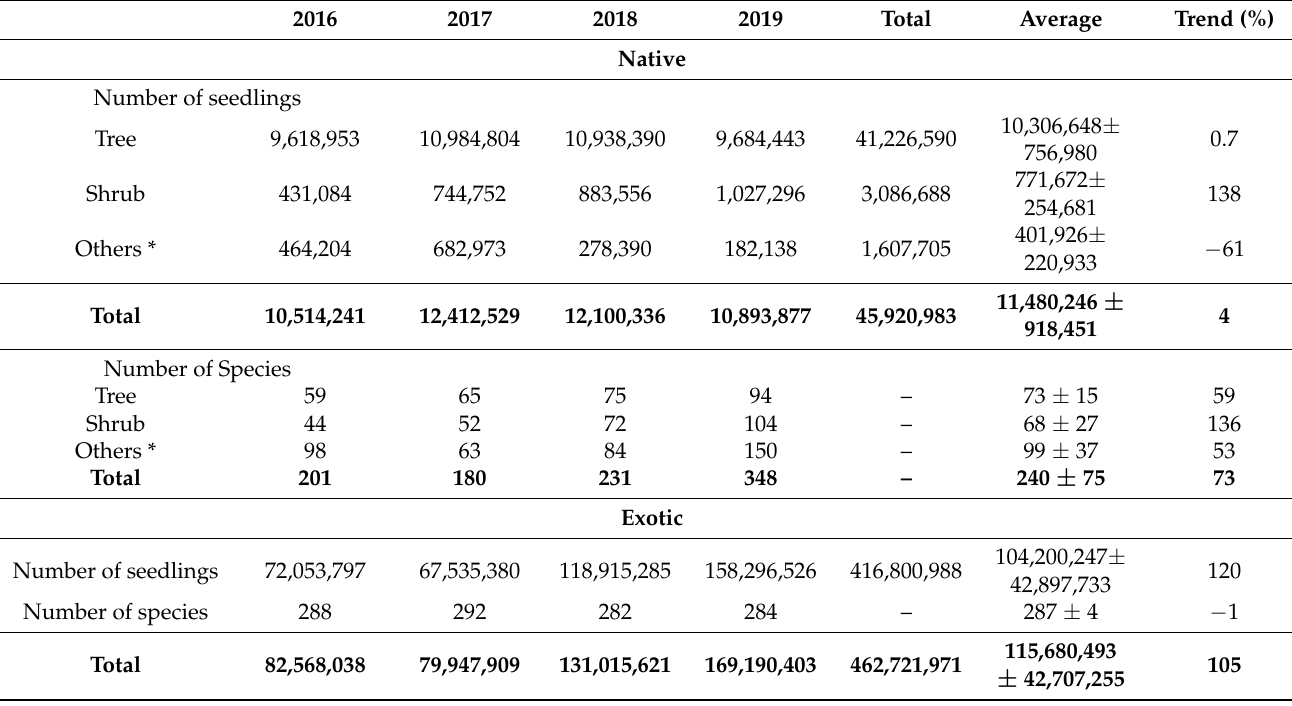
Table 1. Number of native and exotic species and seedlings produced by season between 2016 and 2019. Trend values (%) indicate changes in plant production between 2016 and 2019 (average ±